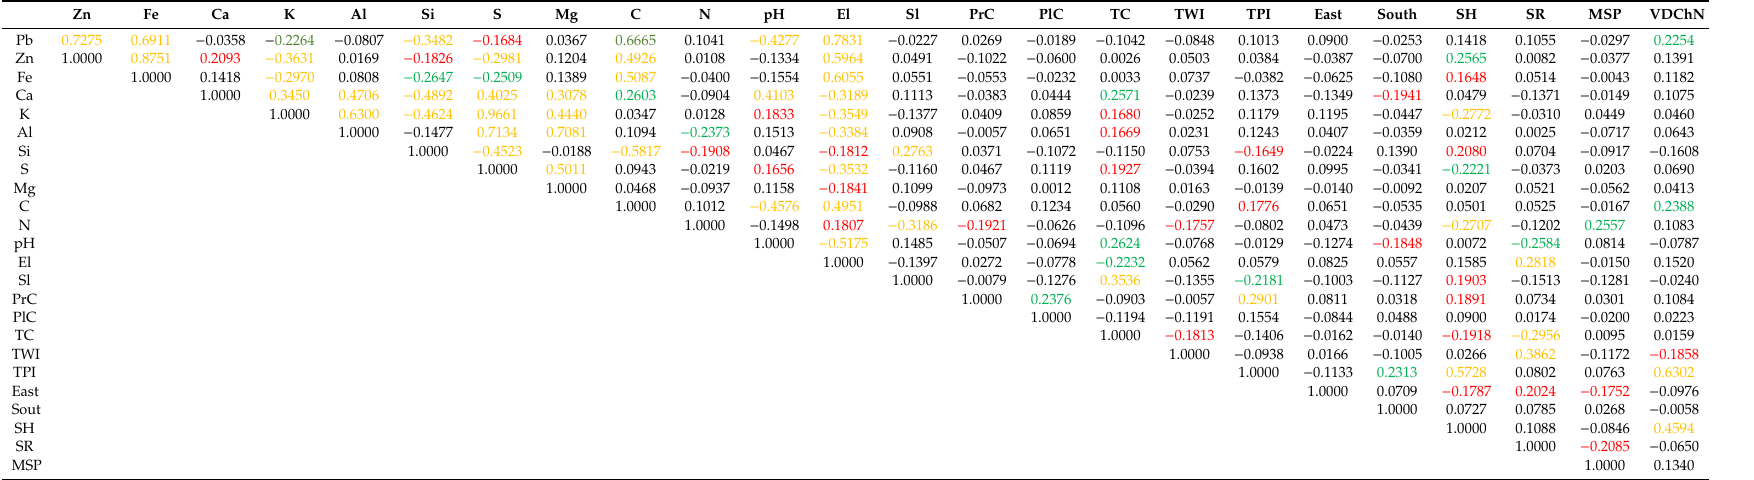
Table A1. Spearman rank correlation matrix for environmental variables. Red p < 0.05; green p < 0.01; orange p <